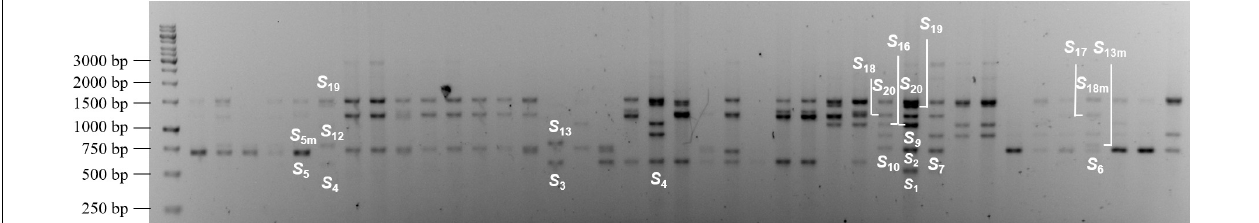
Frontiers in Plant Science |